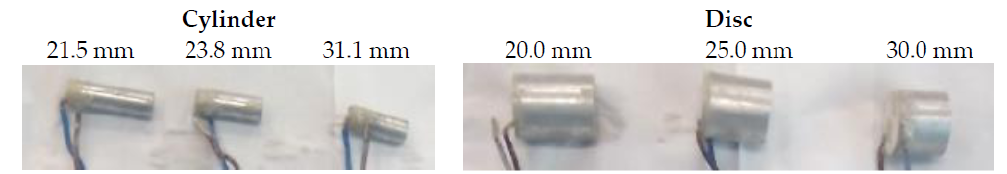
Figure 10. Aluminum matching layers attached to the free ceramics.